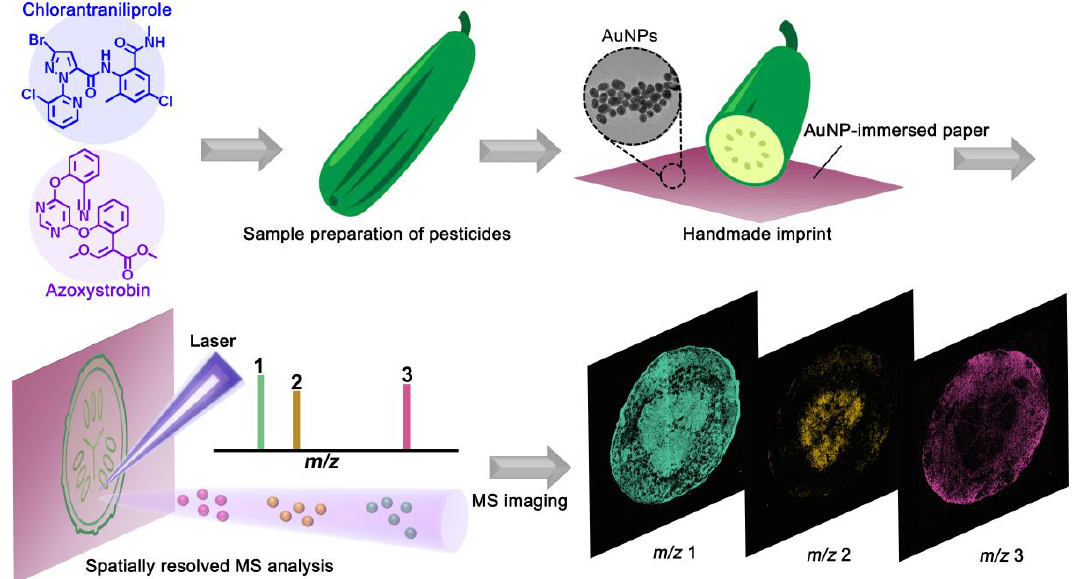
Figure 1. AuNP-immersed paper imprinting mass spectrometry imaging (MSI) platform and workflow. All fruits and vegetables were imprinted on AuNP-immersed paper using manual stamping for the MSI analysis.